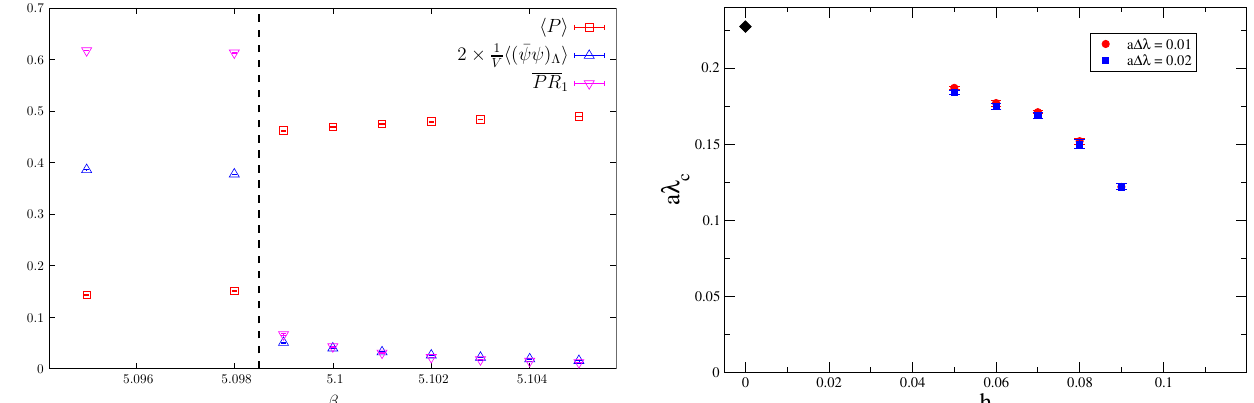
Figure 17. Left : average Polyakov loop (red squares), chiral condensate (upward blue triangles) and average PR of the lowest staggered mode (downward magenta triangle) for N f = 3 unimproved staggered fermions of bare mass m = 0.01 on N t = 4 lattices. The critical coupling β c = 5.0985 is also shown. From Ref. [50]. (Figure adapted from M. Giordano, S. D. Katz, T. G. Kovács, and F. Pittler, J. High Energy Phys. 02, 055 (2017), and used under a CC-BY 4.0 license (https://creativecommons.org/licenses/by/4.0)). Right : mobility edge as a function of the deformation parameter h in trace-deformed SU(3) gauge theory in the high-temperature deconfined phase ( β = 6.0). Here the critical deformation parameter for reconfinement is h c = 0.1. The black diamond is the h = 0 result of Ref. [51]. From Ref. [55]. (Figure adapted from C. Bonati, M. Cardinali, M. D’Elia, M. Giordano, and F. Mazziotti, Phys. Rev. D 103, 034506 (2021), and used under a CC-BY 4.0 license